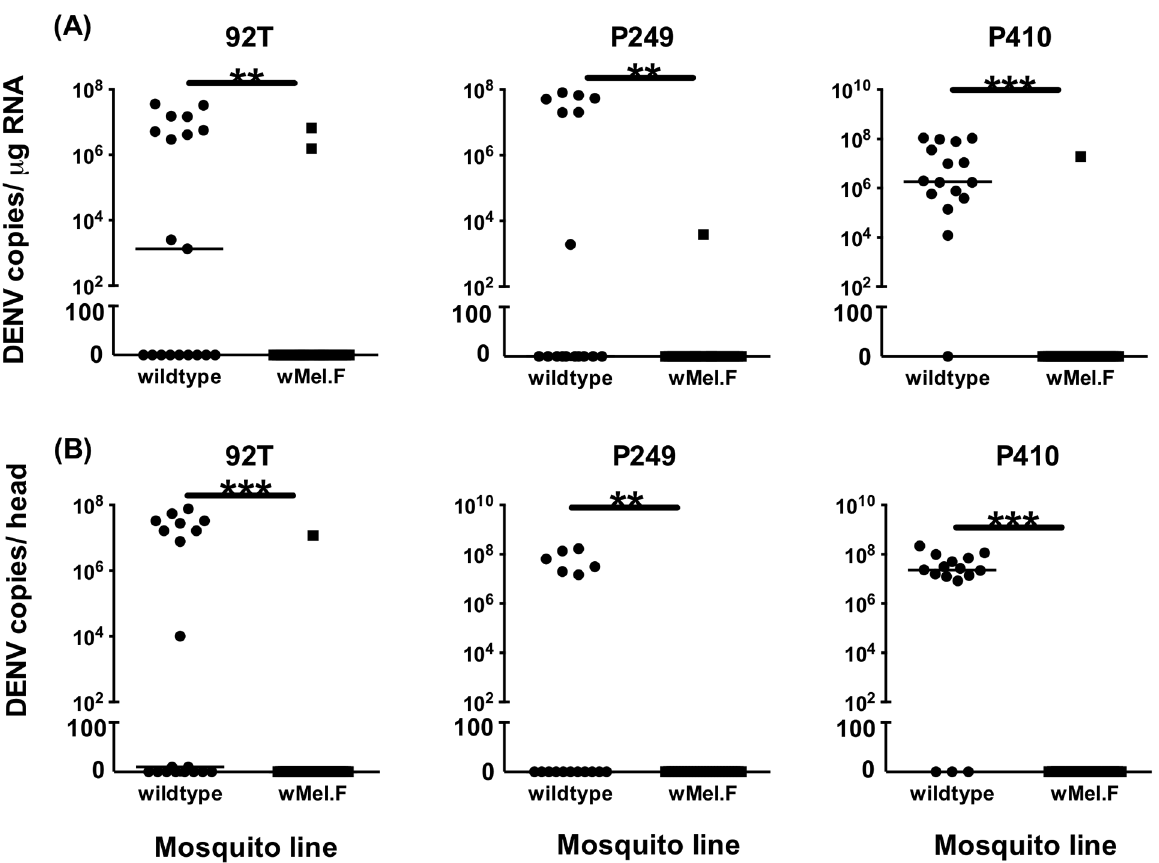
Figure 1. Experiment 1: DENV replication in wildtype and field-released ( w Mel.F) A.aegypti . DENV replication in bodies (A) and heads (B) of mosquitoes challenged with three strains (DENV2-92T, DENV1-P249, DENV2-P410), assayed at 14 days post-infection. DENV levels determined using one-step qRT-PCR and expressed as copies per 1 m g of total RNA. Bars denote medians. P , 0.05 (*), P , 0.01 (**), P , 0.001 (***). Each point represents an individual mosquito.